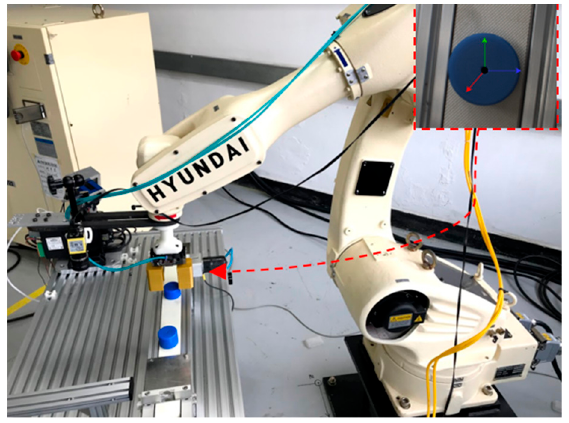
Figure 12. Trajectory that the robot was taught.